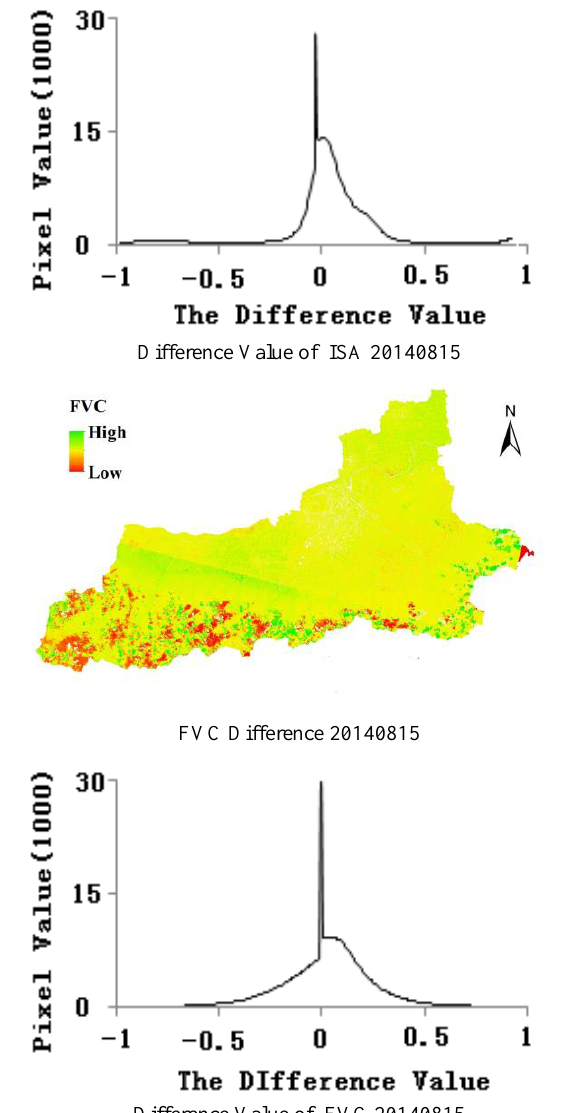
Figure 6. The difference between Landsat8 &ESTARFM